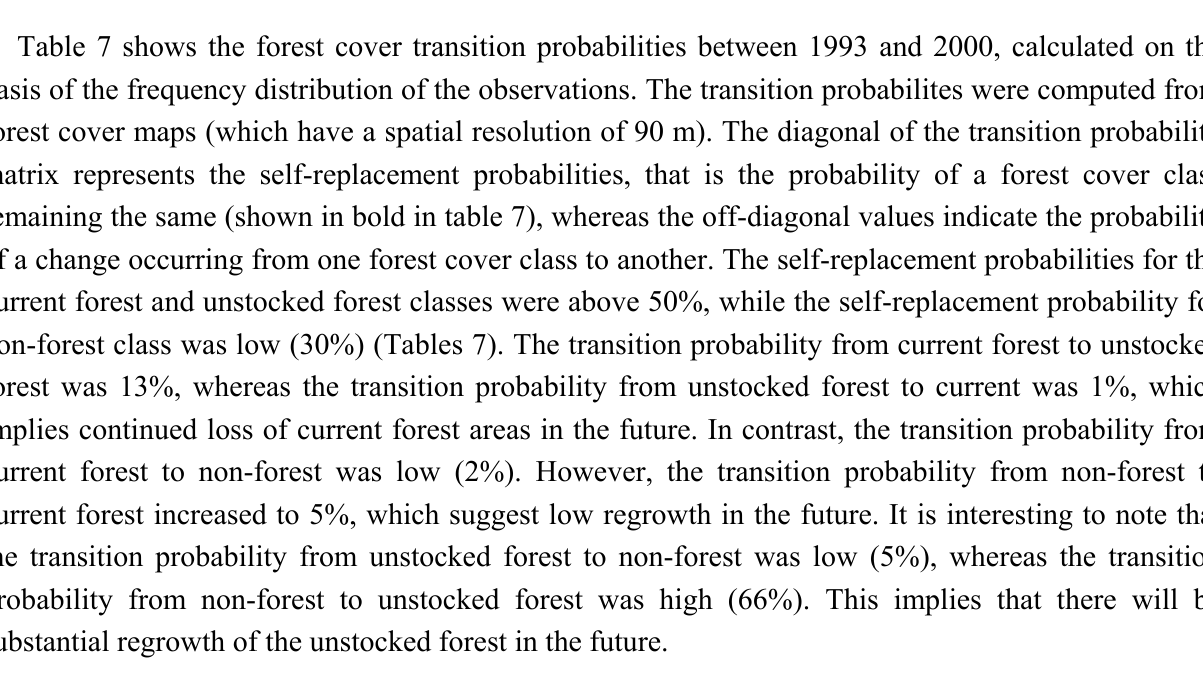
Table 7. Forest cover changes transition probabilities